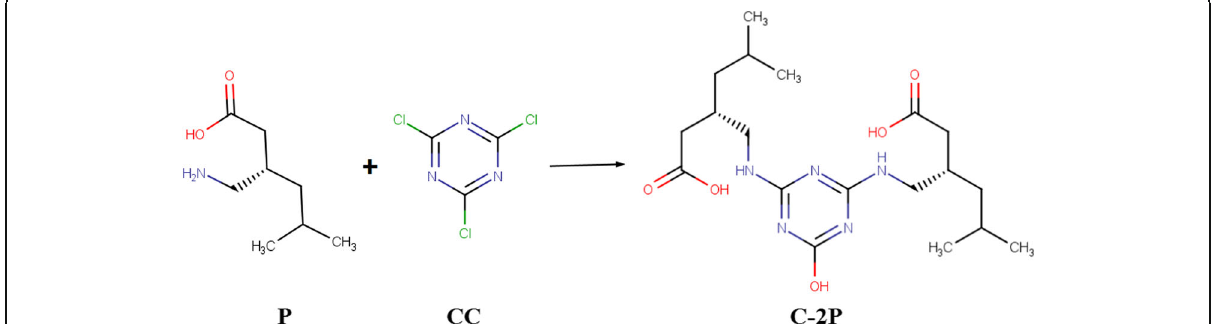
Fig. 1 Synthesis of the organic ligand